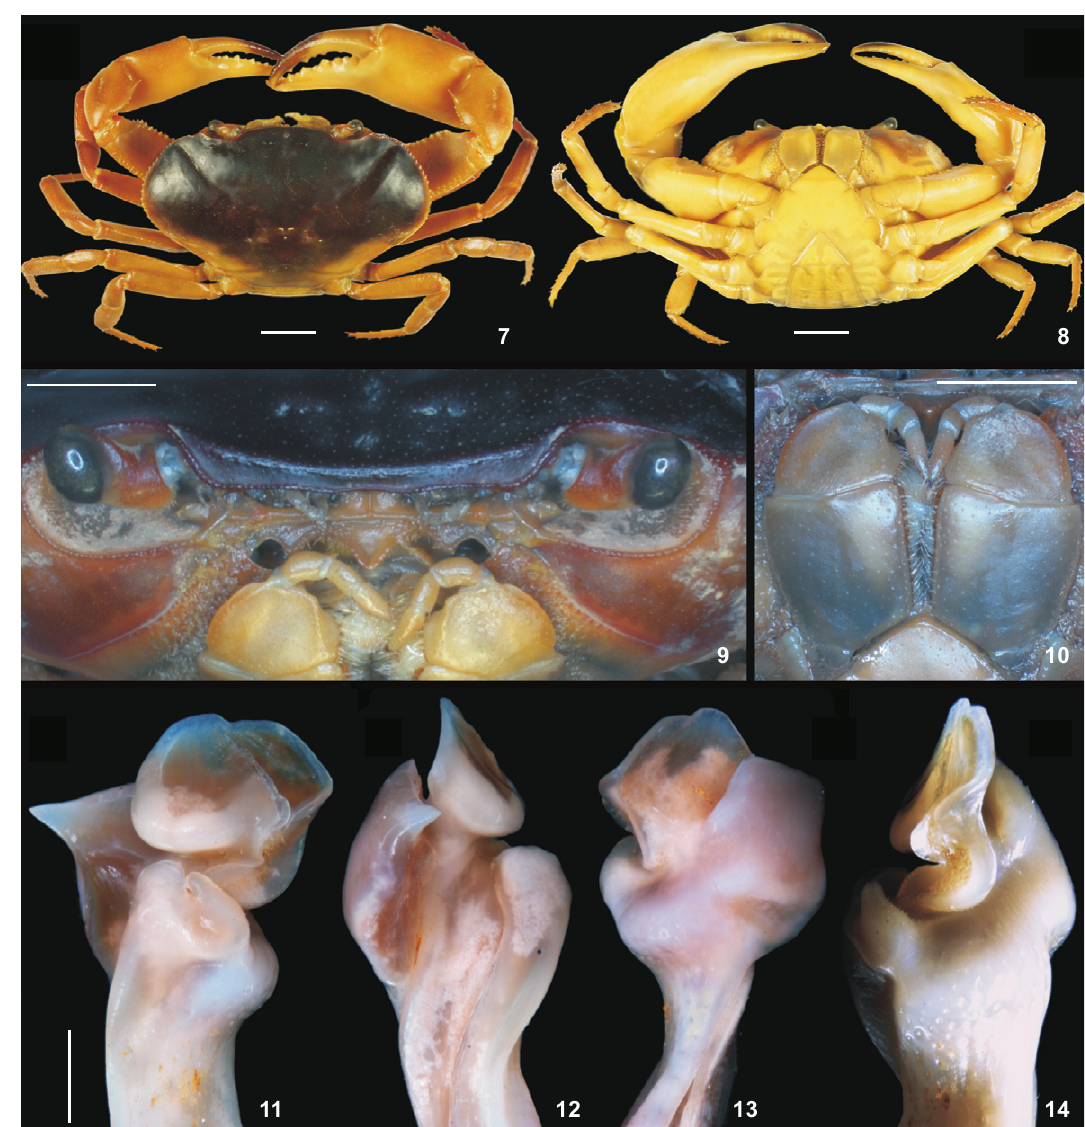
Figures 7-14. Kingsleya castrensis sp. nov. , male, paratype, MZUSP 26394: (7) habitus, dorsal view; (8) habitus, ventral view; (9) frontal view; (10) pair of third maxillipeds, frontal view. Male, paratype, left first gonopod, MZUSP 23393: (11) caudal-mesial view; (12) mesial-cephalic view; (13) lateral view; (14) idem, caudal view. Scale bars: 7, 8 = 10 mm, 9, 10 = 5 mm; 11-14 = 1